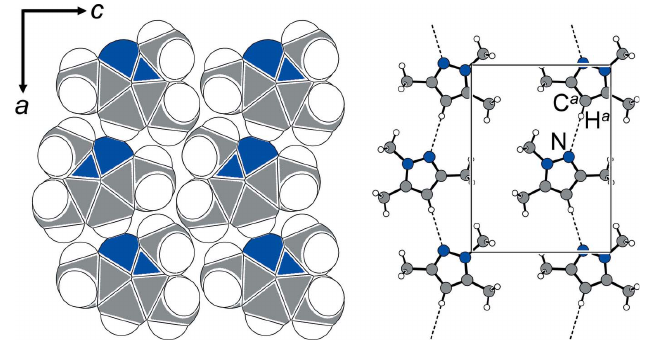
Figure 2 Packing in the (010) plane (Spek, 2020). Non-classical C—H (cid:2)(cid:2)(cid:2) N contacts are shown as dashed lines: d (N (cid:2)(cid:2)(cid:2) H a ) = 2.56 A˚ ; / (C a —H a (cid:2)(cid:2)(cid:2) N) = 179 (cid:4) . (cid:5) y , 3 (cid:5) z . Symmetry code: ( a ) (cid:5) 1 + x , 1 2 2 2